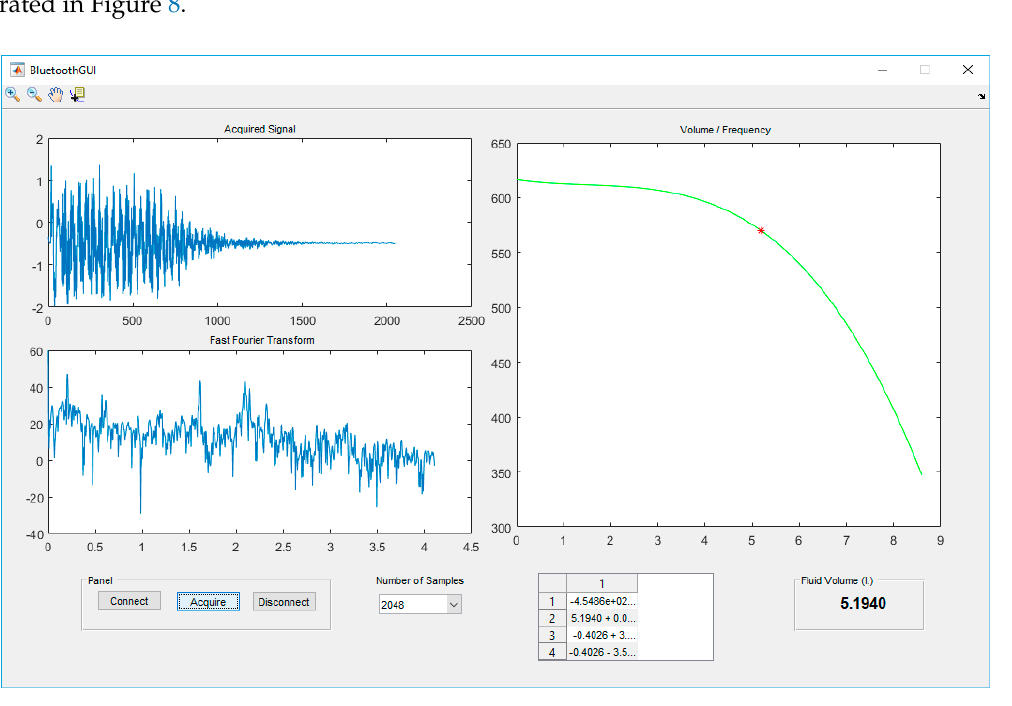
Figure 8. The MATLAB graphical user interface (GUI).